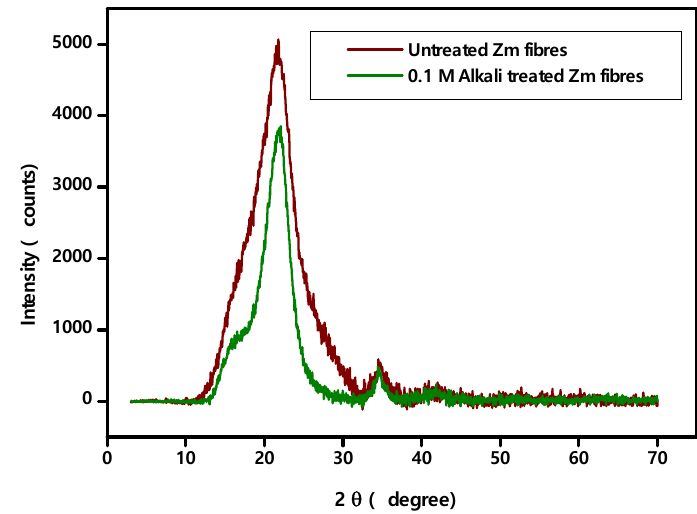
Figure 4. p-XRD pattern Zea mays fibres. Figure 4. p-XRD pa tt ern Zea mays fi bres.